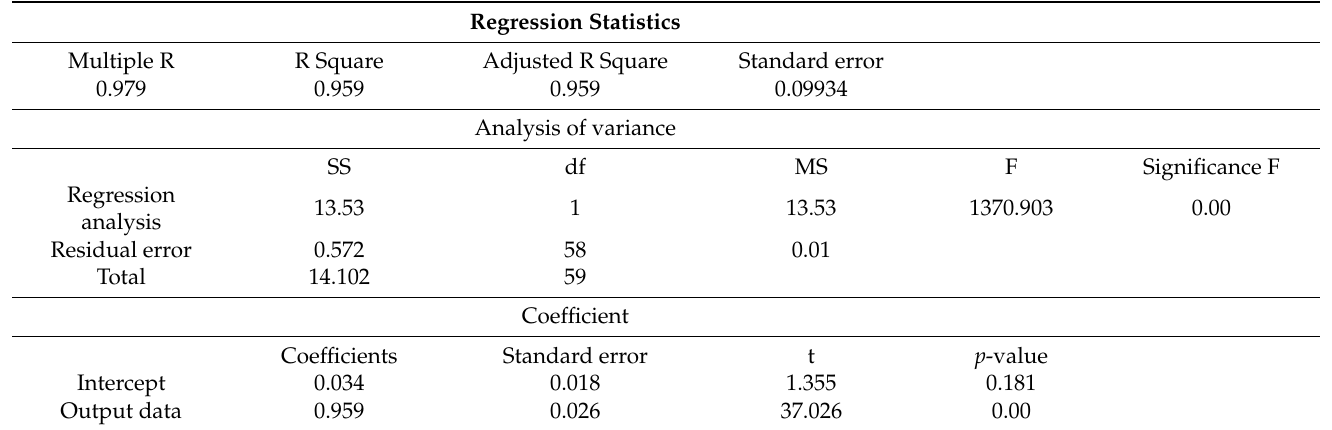
Table 2. Correlation parameters of regression equation test.